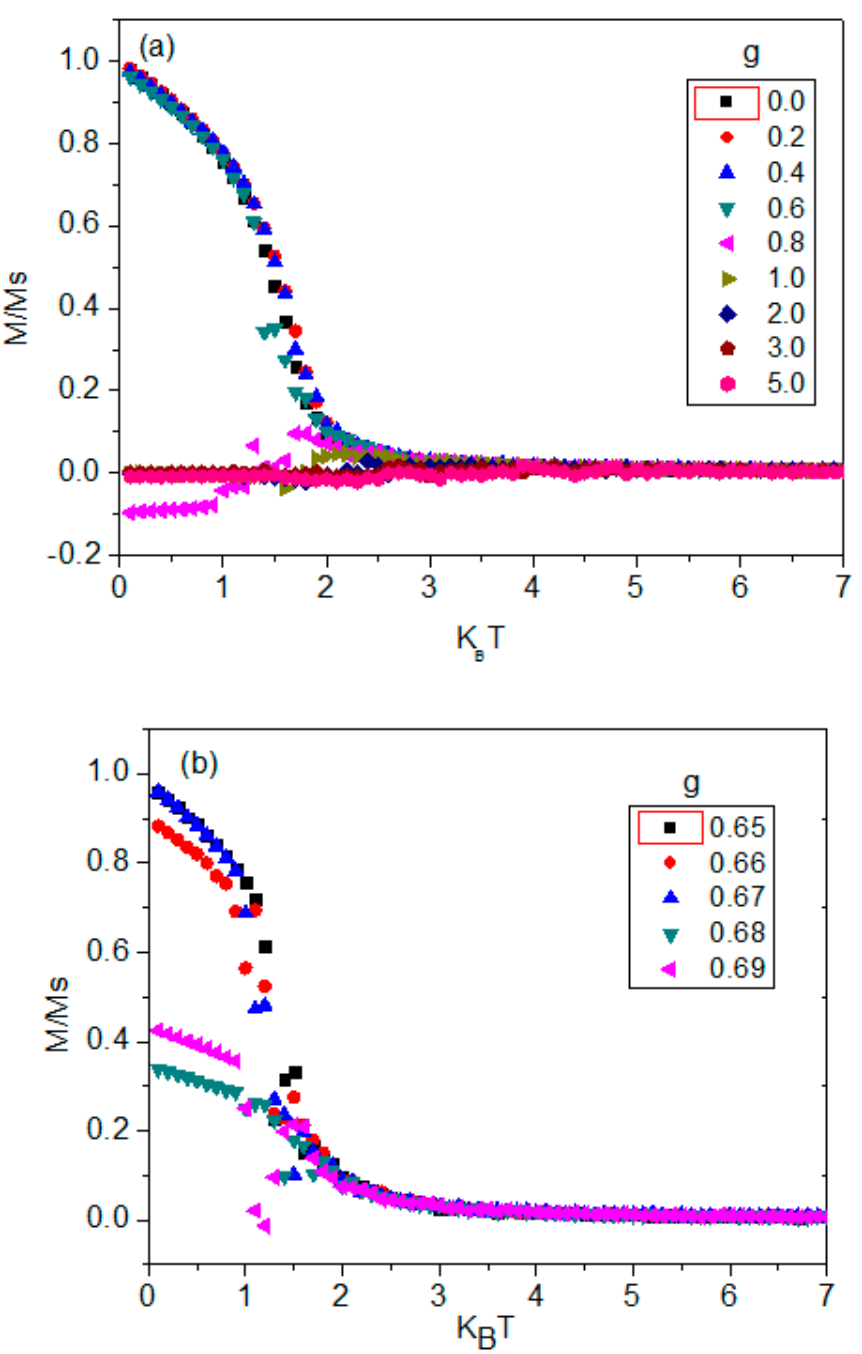
Figure 3. ( a ) Normalized magnetization curves vs. temperature at different values of the dipolar interaction parameter g, in a magnetic layer with thickness, d = 5 unit cells; ( b ) Magnetization curves vs. temperature at the interval where the ferromagnetic order decays. Curves were obtained at P / Y = 0.002.